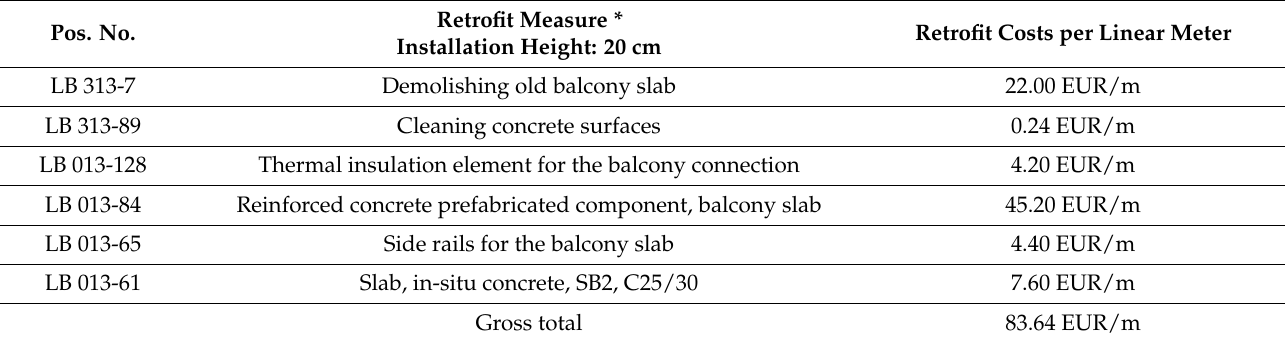
Table A12. Retrofit components and costs of the thermal bridge retrofit of a balcony slab [38,39]. Pos.